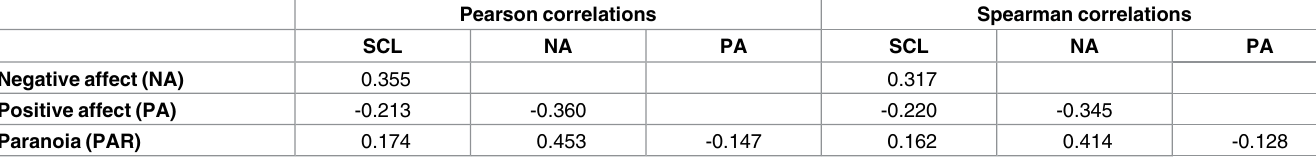
Table 2. Pearson product-moment and Spearman rank correlations of the